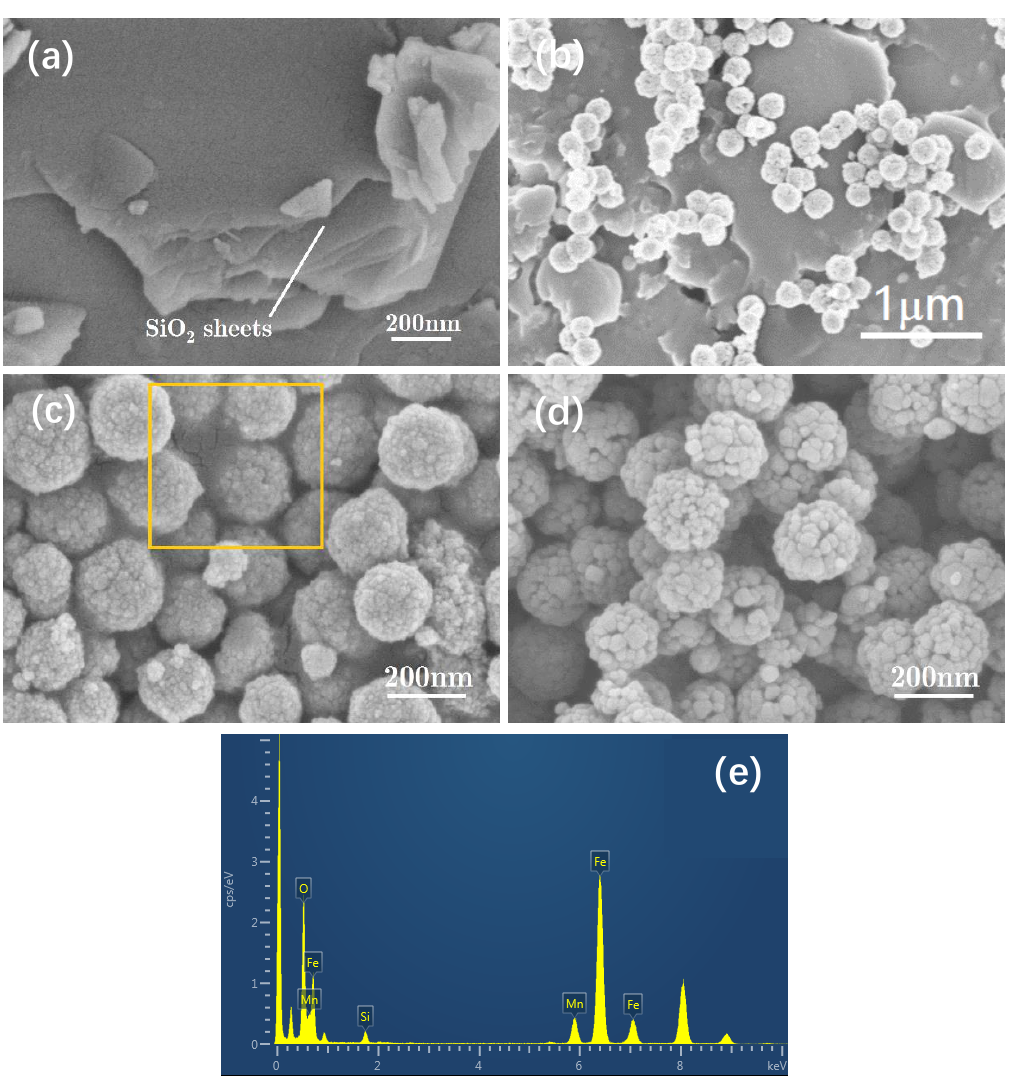
Figure 2. SEM images of sample S1 ( a ), sample S2 ( b ), sample S3 ( c ), sample S4 ( d ) and the Energy Dispersive Spectrometer (EDS) spectrum of sample S3 ( e ).